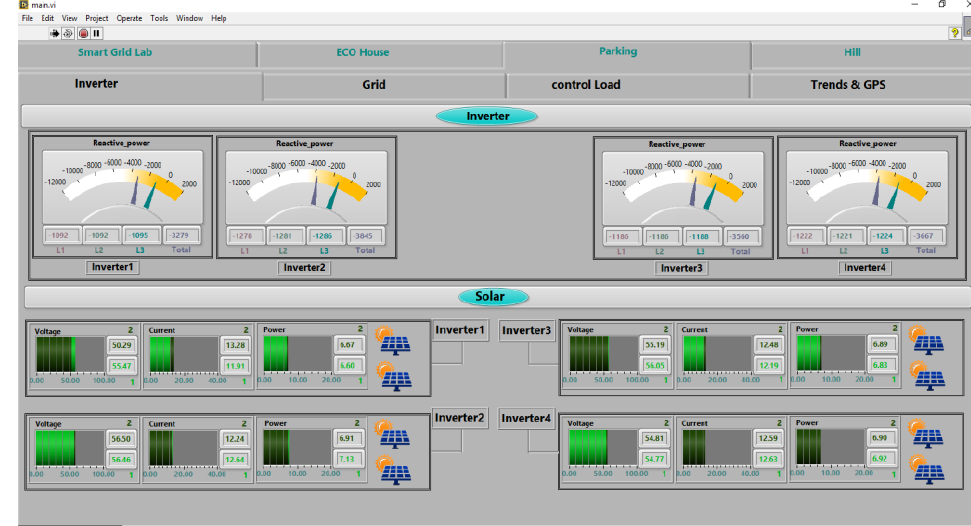
Figure 17. LabVIEW visualization of inverter’s DC-side quantities.